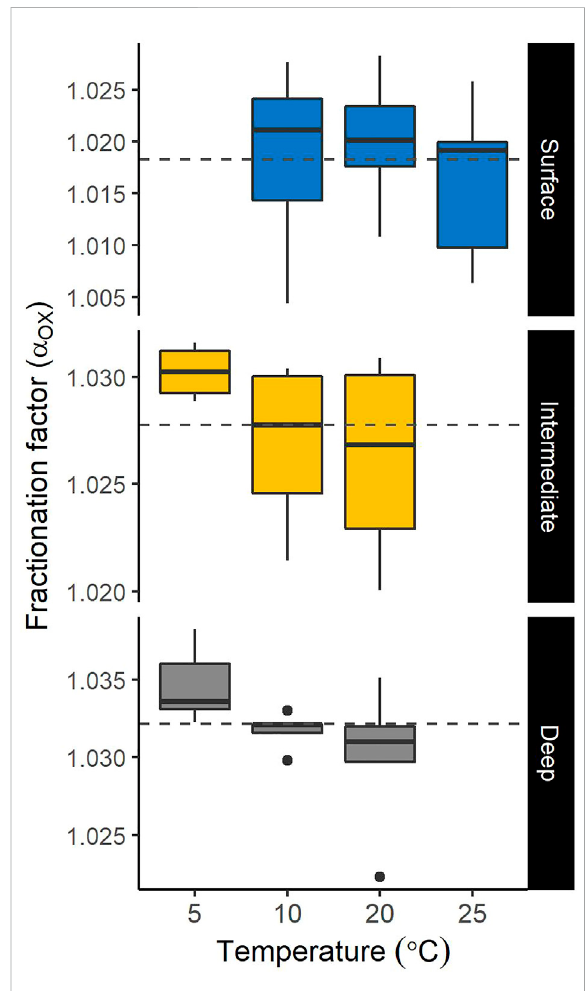
Variation of the isotopic fractionation factor ( α ox ) during aerobic CH 4 oxidation across different layers and incubation temperatures in the study lakes. Note that α ox estimations from all lakes are pooled for a given incubation temperature. Horizontal dashed lines represent the average for each layer across all incubation temperatures. The boxplots represent the median, fi rst and third quartiles (hinges) and the 1.5 × interquartile range correlation with TP (R 2 = 0.31, p < 0.0001; Supplementary Figure S3).